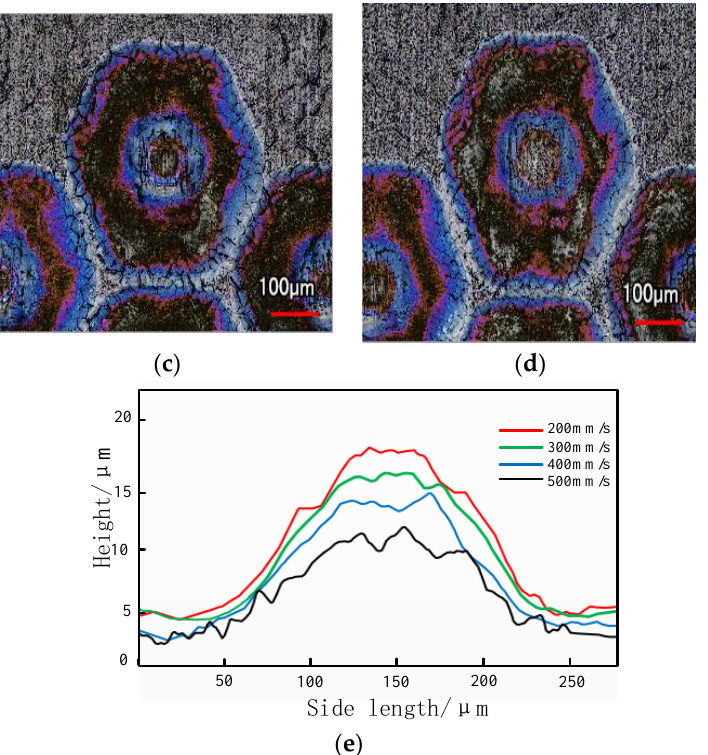
Figure 9. The relationship between machining speed and the appearance of the surface. ( a ) v = 200 mm/s, ( b ) v = 300 mm/s, ( c ) v = 400 mm/s, ( d ) v = 500 mm/s, ( e ) Contour graph for different speeds.